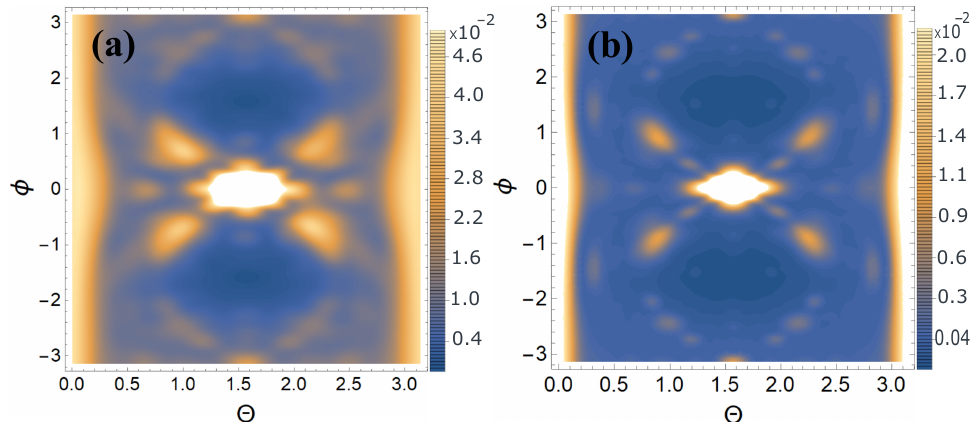
Figure 3. The figures show the 2D USP scattering spectra presented as contour plots: ( a ) the diamond unit cell with NV centre (see Figure 1a), ( b ) this on the diamond structure presented in Figure 1b. The calculation was done using Equation (3). The angles θ and φ are represented in a spherical coordinate system, where the z axis is directed upwards and y is in the direction of the incident